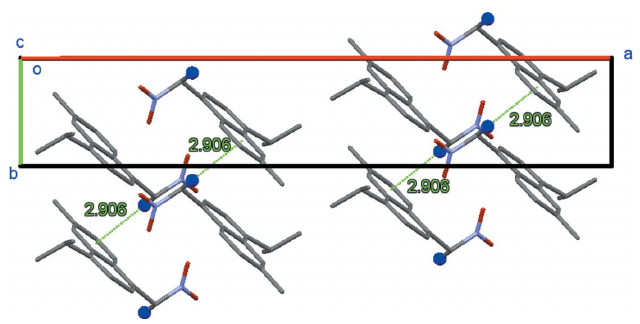
Figure 2 A partial view of the crystal packing, showing the C—H (cid:3)(cid:3)(cid:3) (cid:5) interactions as green lines (see Table 2; the H atom involved is shown as a blue ball).